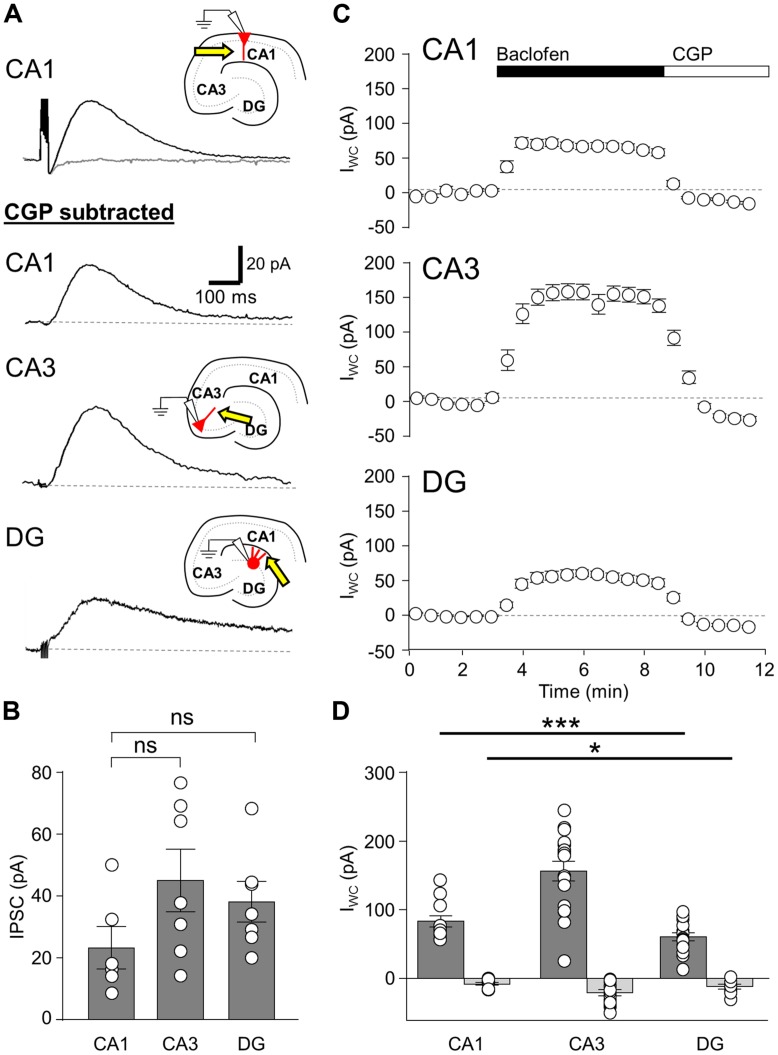
Synaptic and agonist-induced GABABR-mediated currents in hippocampal principal cells. (A, upper), IPSCs elicited in a CA1 PC by a train of five stimuli at 200 Hz before (black trace) and after application of the specific GABABR-antagonist CGP-55845 (CGP, 5 μm, gray trace). (A, lower), IPSCs elicited by a train of five stimuli in CA1 PCs (top), CA3 PCs (middle) and DGCs (bottom), following subtraction of the CGP trace. Inset illustrates the arrangement of the recording pipette and the extracellular stimulation site (arrow). (B) Summary bar chart shows the mean amplitudes of GABABR-mediated IPSCs produced by 5-stimuli in CA1 PCs (CA1, n = 6), CA3 PCs (CA3, n = 7), and DGCs (DG, n = 7). (C) Mean change in IWC plotted against time, before and during baclofen and subsequent CGP application (CA1 PCs, n = 5; CA3 PCs, n = 9; DGCs, n = 8). (D) Bar chart of the average peak IWC measured for baclofen (dark gray) and CGP (light gray) in CA1 PCs (baclofen: n = 12, CGP: n = 11), CA3 PCs (baclofen: n = 17, CGP: n = 13), and DGCs (baclofen: n = 15, CGP: n = 9). All average data is overlain by the values from the individual experiments (open circles). Statistics shown: ns = P > 0.05, *P < 0.05, ***P < 0.001; one-way ANOVA.